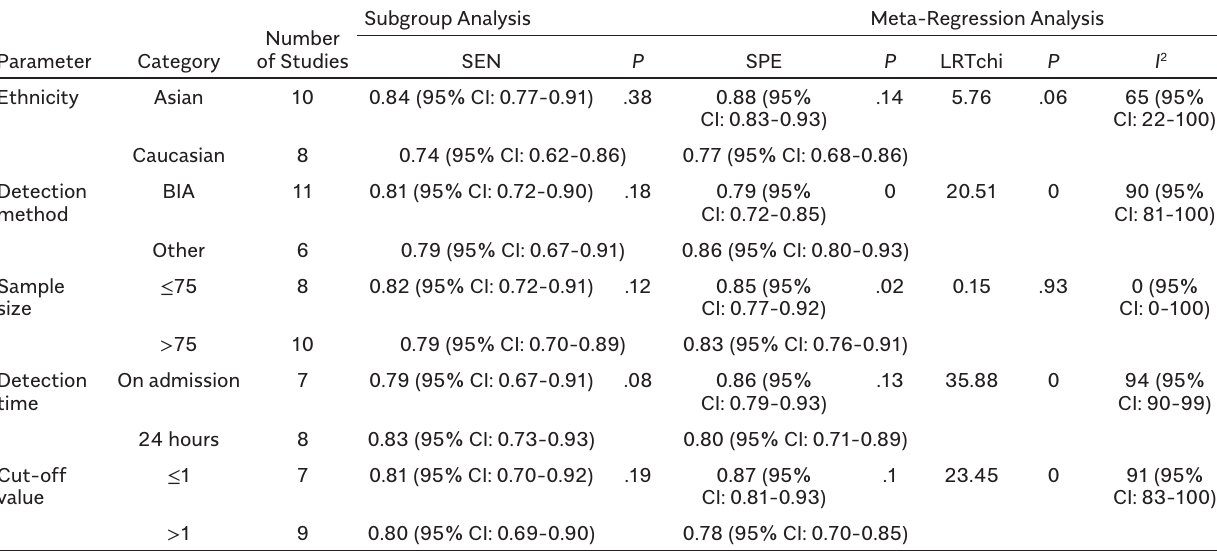
Supplementary Table 1. Meta-Regression Analysis and Subgroup